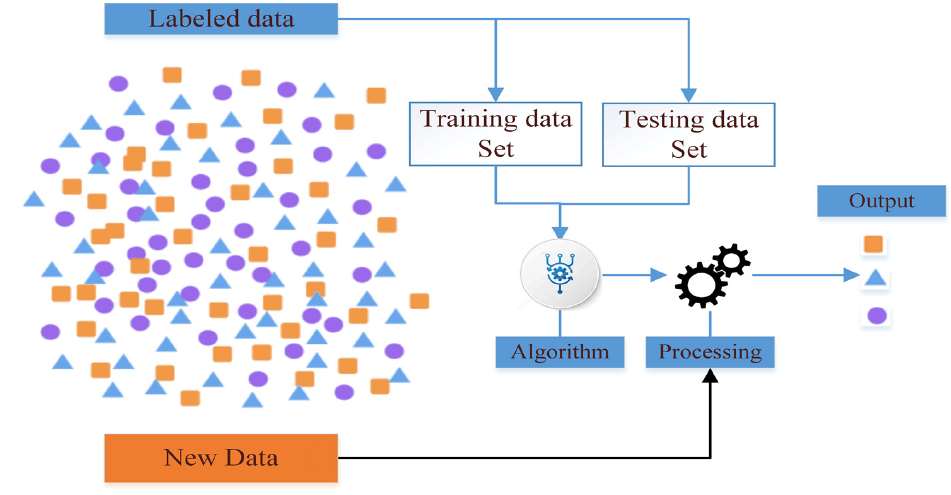
Figure 7. Supervised learning processes.